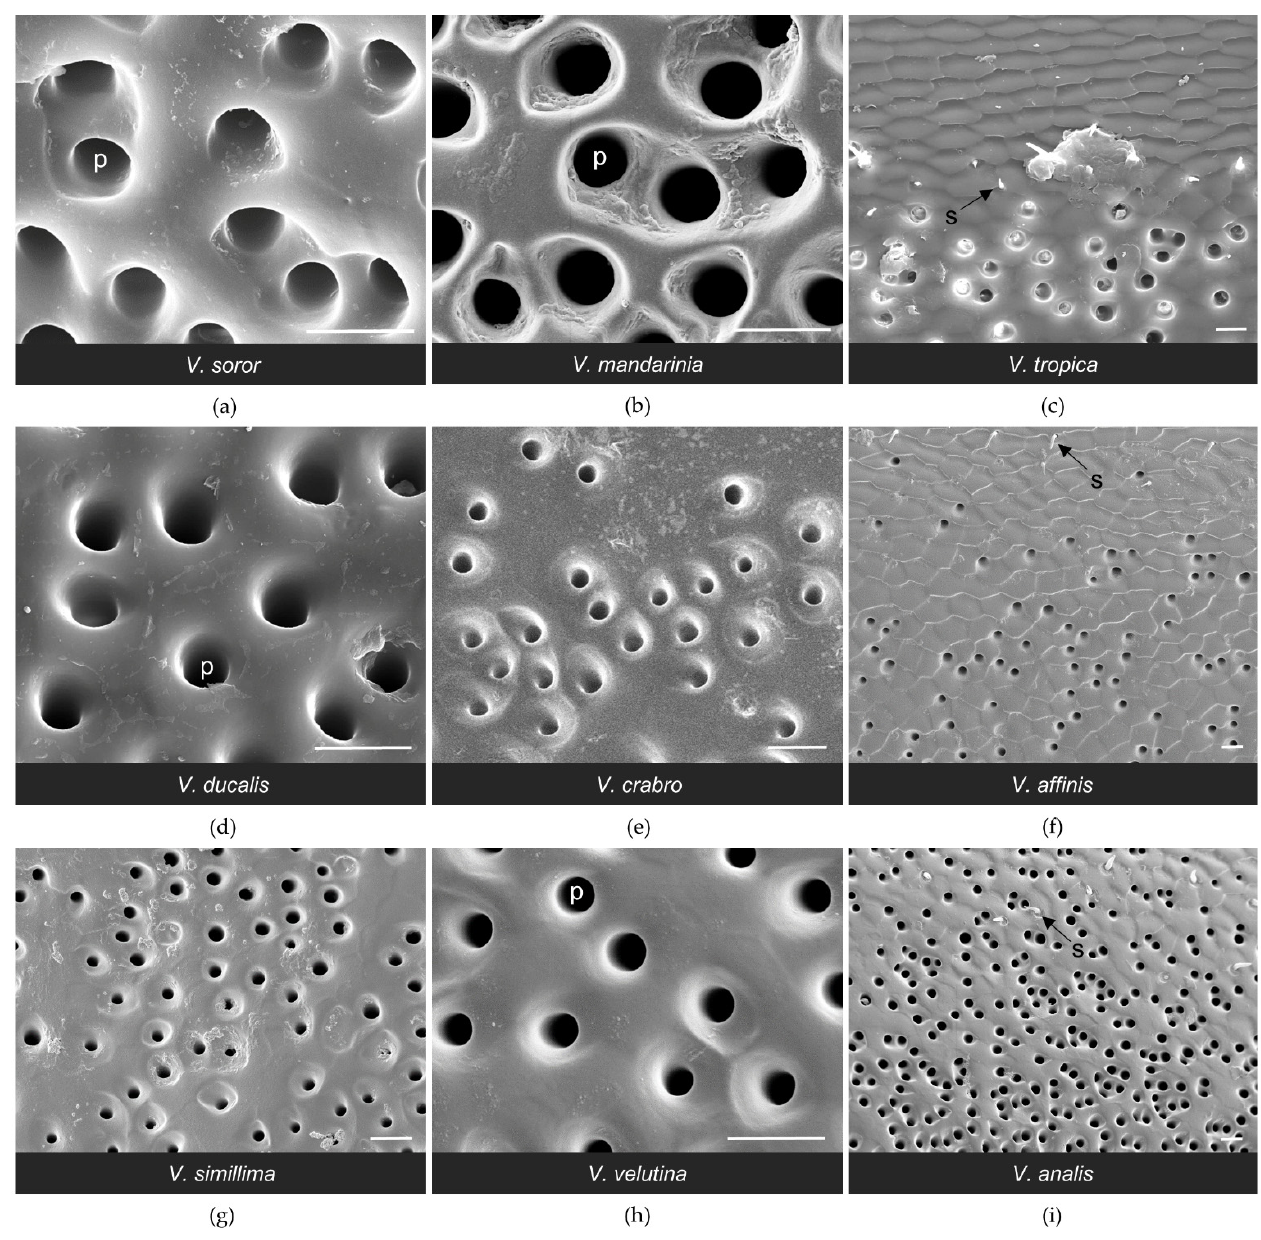
Figure 9. SEM images of nine Vespa species ( a – i ) showing high-resolution detail for pore openings of the Richards gland. Anterior is at the top. Species are presented in the order in which they appear in the phylogeny depicted in Figure 1. Bars indicate 10 μ m for scale; p = pore, s = seta.